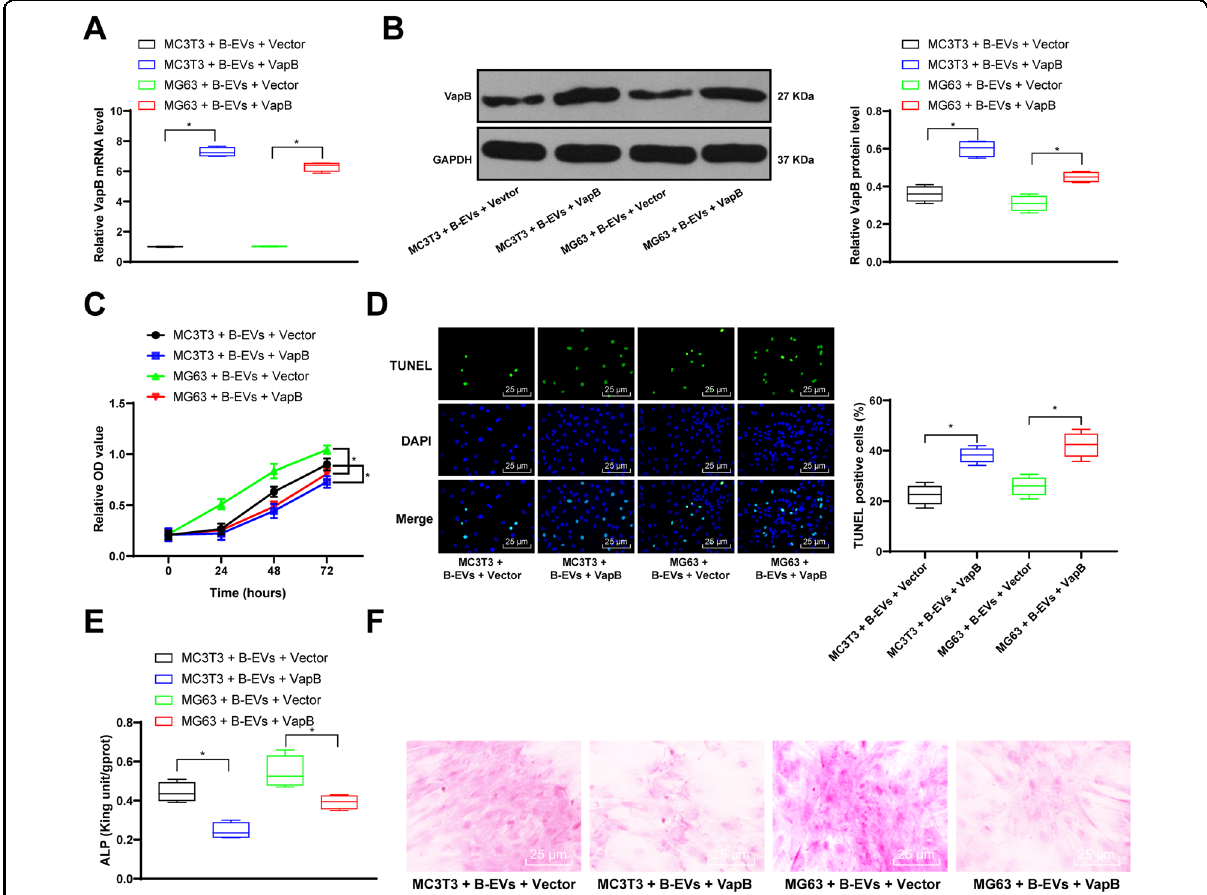
Fig. 7 VapB overexpression attenuates B-EV effects. The EVs were extracted from BMSCs and treated with VapB overexpression plasmids on MC3T3 and MG63 cells. And the control was cells were treated with B-EVs and Empty Vector. A , B RT-qPCR and western blot analysis were performed to determine VapB mRNA and protein levels. C MC3T3 and MG63 cell viability was determined by MTT assay. D TUNEL staining was performed to determine apoptosis of MC3T3 and MG63 cells. E ALP activity in MC3T3 and MG63 cells was determined by ALP assay kit. F Alizarin red staining was performed to validate MC3T3 and MG63 bone differentiation ability. Data are expressed as mean ± standard deviation. Two-way ANOVA and Tukey ’ s multiple comparisons test were used to determine statistical signi fi cance. * p < 0.05. Four independent experiments were